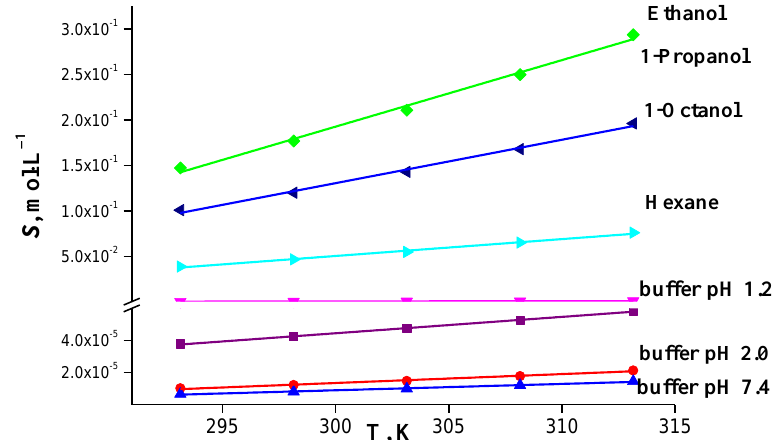
Figure 6. Temperature dependences of IVZ solubility in selected solvents.